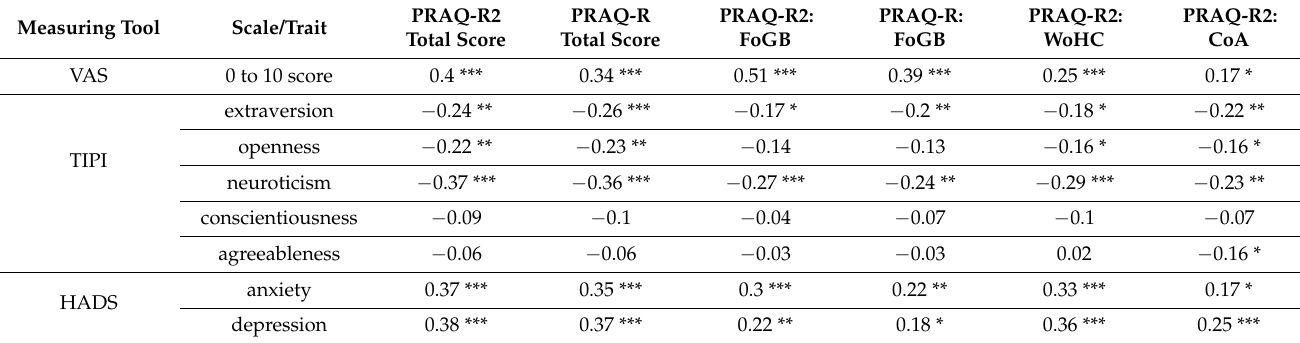
Table 5. Correlations between the PRAQ-R/R2 and other anxiety measurement tools (Spearman’s rho coefficient). Measuring